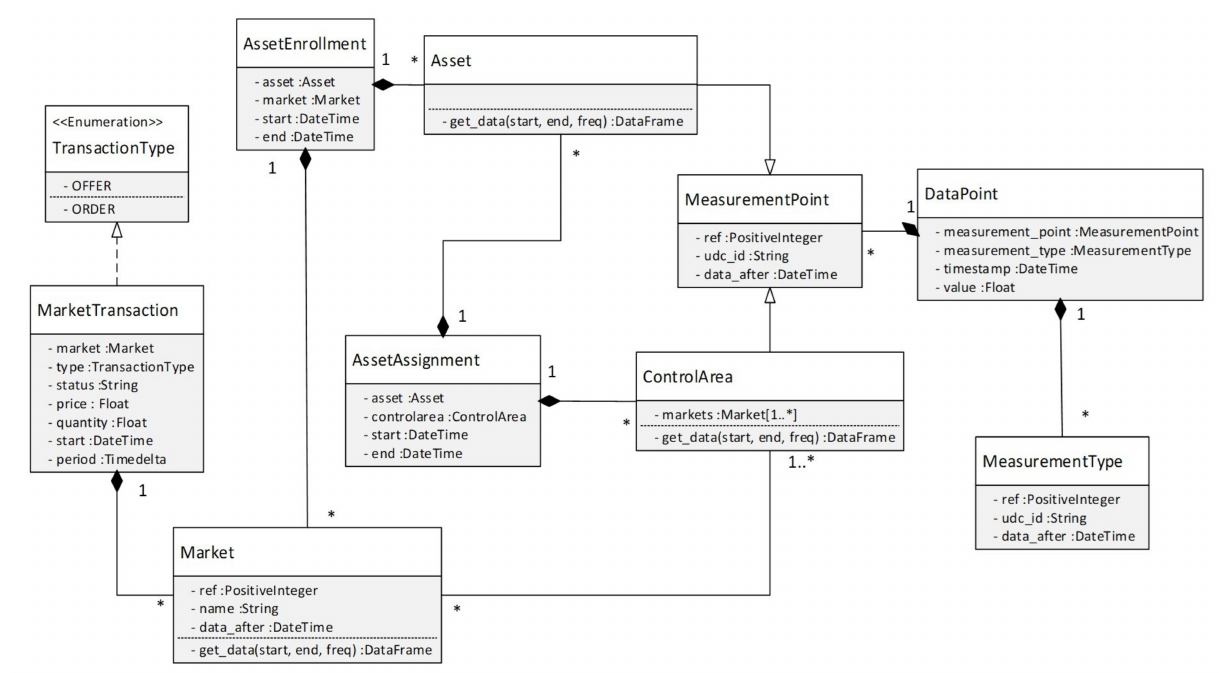
Figure 2. UML Class diagram of the data